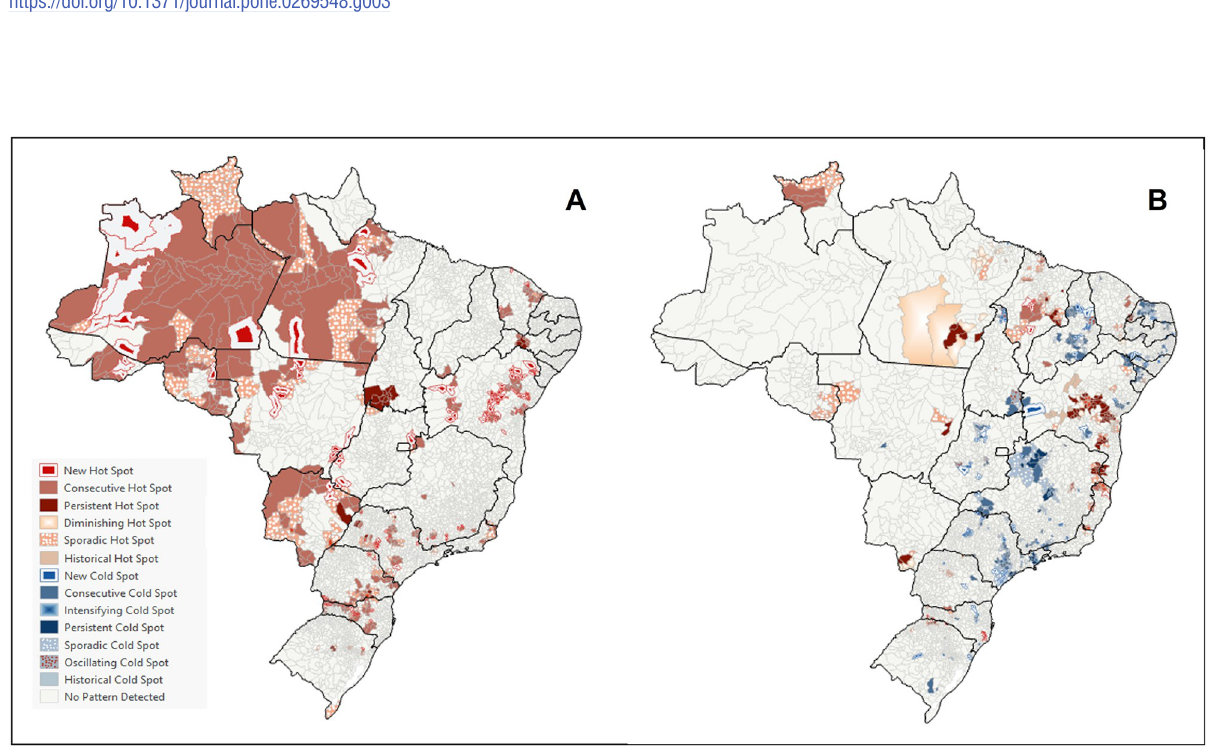
Fig 4. Emerging hotspot analysis, from a space-time cube, of PCSC related to prenatal care and childbirth and children under two years old. Brazil, 2008–2019. (A) PCSC in women, for causes related to prenatal care and childbirth. (B) PCSC in children under two years of age.